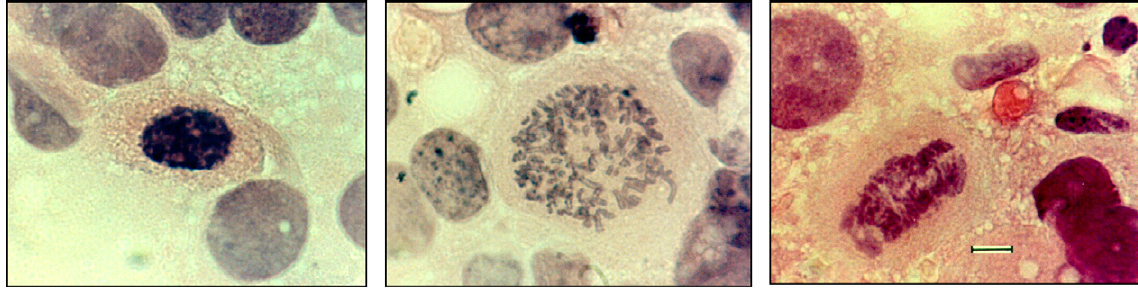
Fig. 3. Imprint cytology from breast cancer, HE stained. Specimens were destained and subject to Feulgen procedure for microphotometry. Prophase 6.1c (left), metaphase 7.2c, anaphase 5.2c. Bar: 10 µ m.